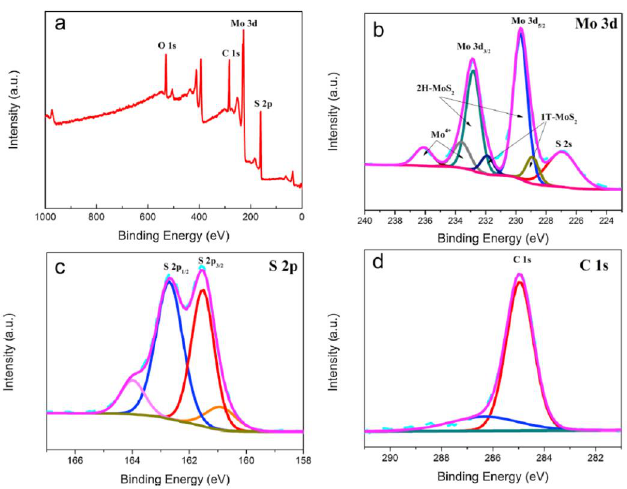
Figure 23. Full XPS spectra of ( a ) MoS 2 /candle soot composite, ( b – d ) high-resolution XPS spectra of Mo 3d, S 2p, and C 1s for MoS 2 /candle soot composite. Reproduced with permission from [108].